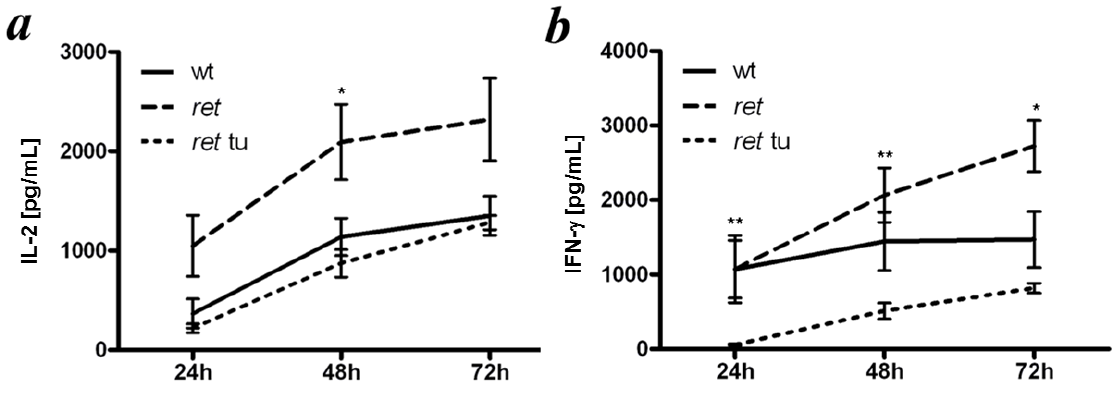
Figure 3. Reactivity of spleen T cells from ret transgenic mice upon antigen-unspecific stimulation. Splenocytes from tumor free ( ret ) or tumor bearing transgenic mice ( ret tu) or non-transgenic littermates (wt) were incubated overnight with anti-CD3 and anti-CD28 mAbs. The amount of secreted IL-2 ( a ) and IFN- γ ( b ) was determined by ELISA. Data (mean ± SEM of 4–5 mice per group) are expressed as pg/mL. * p < 0.05, ret versus wt or ret versus ret tu groups. ** p < 0.05, ret versus ret tu